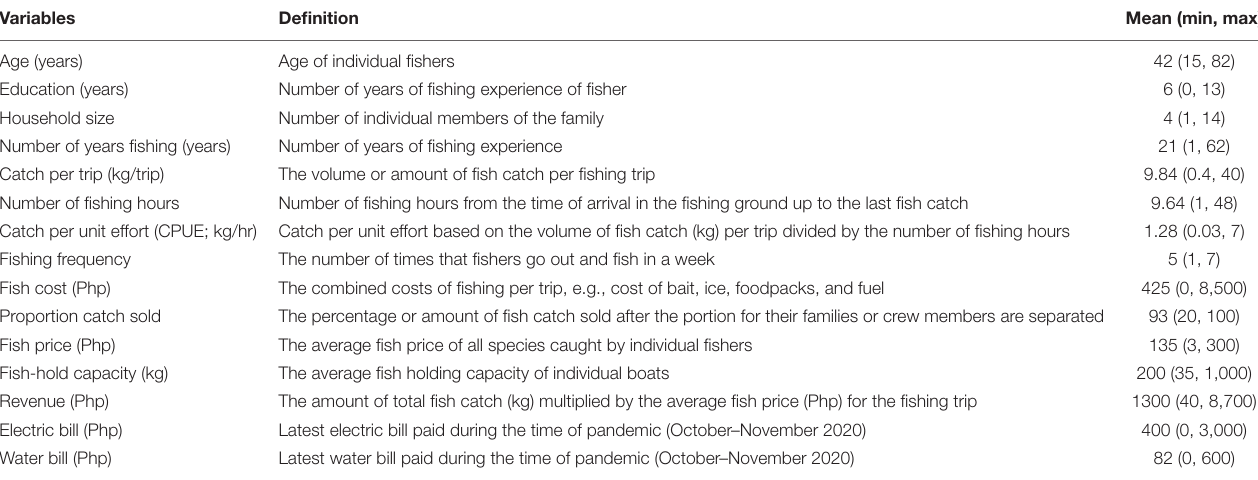
TABLE 2 | Mean and range of variables used in the data